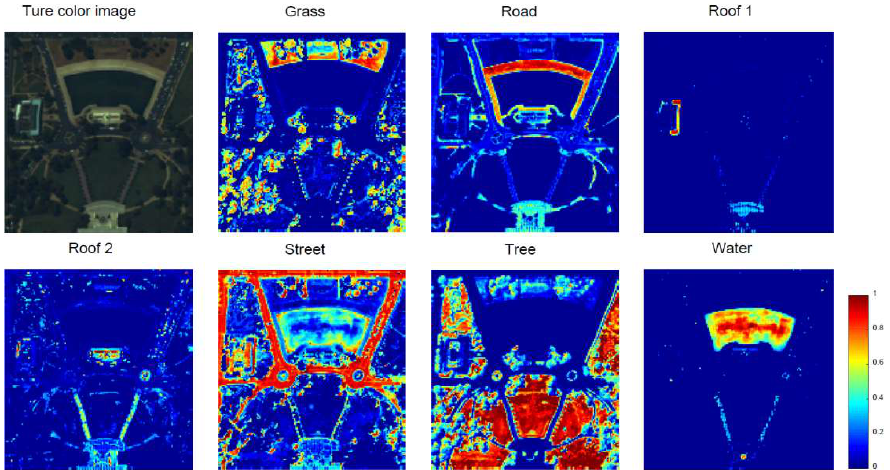
Figure 16. The abundance result of Washington DC Mall estimated by the proposed method. Table 4. Experimental results of Washington DC Mall dataset.